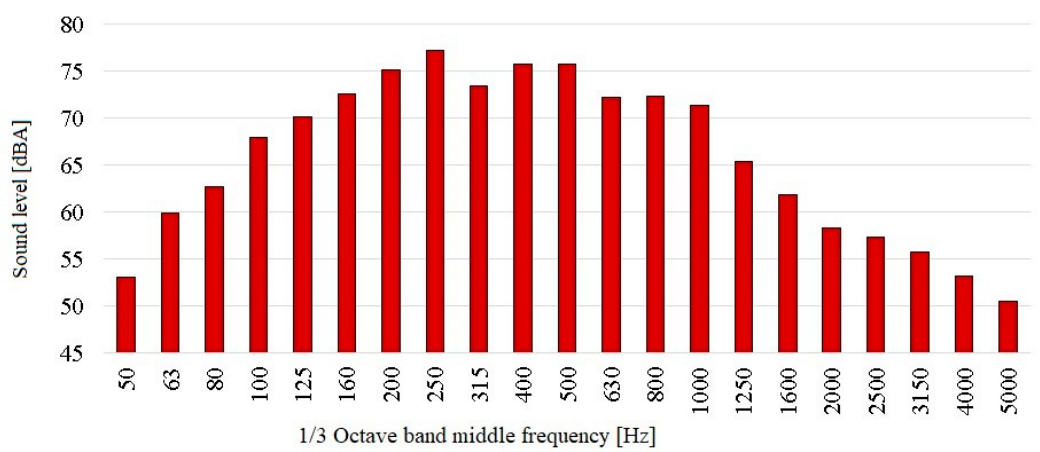
Figure 7. Results of measurements to determine the performance of the sound absorbing material inside the sound cover.